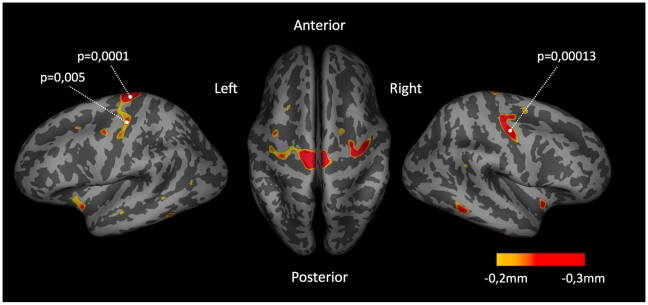
Whole brain cortical thickness.Whole brain cortical thickness measurements in patients with ALS compared to healthy controls. Cortical areas with (uncorrected) p-values <0.01 are marked. The threshold for this illustration was set at 0.2 mm cortical thickness reduction in ALS.